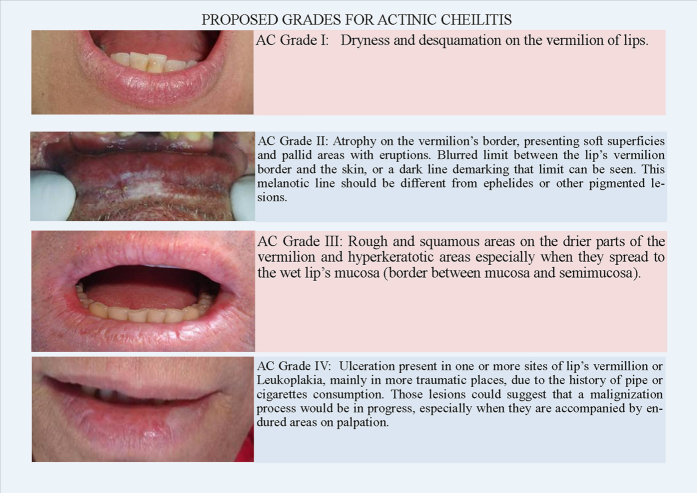
Illustration showing the four proposed grades to the AC.